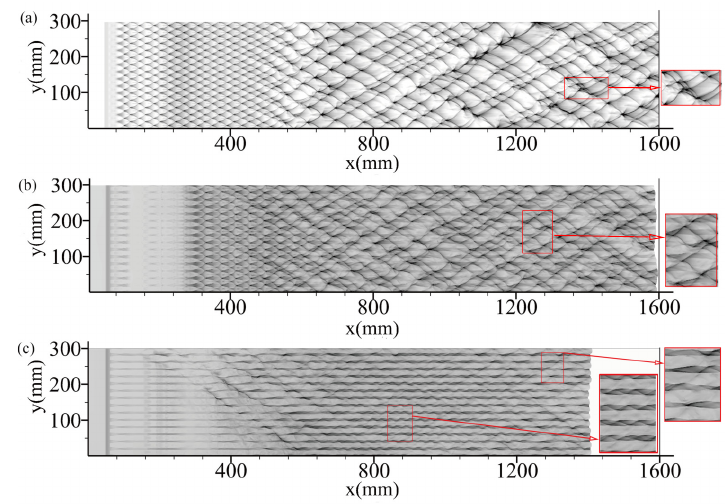
Figure 14. Numerical smoked foils for cases front under artificial perturbations with different amplitudes s = 20 ∆ I and k R = 4 s − 1 , ( a ) A = 15 K, ( b ) A = 55 K, and ( c ) A = 105